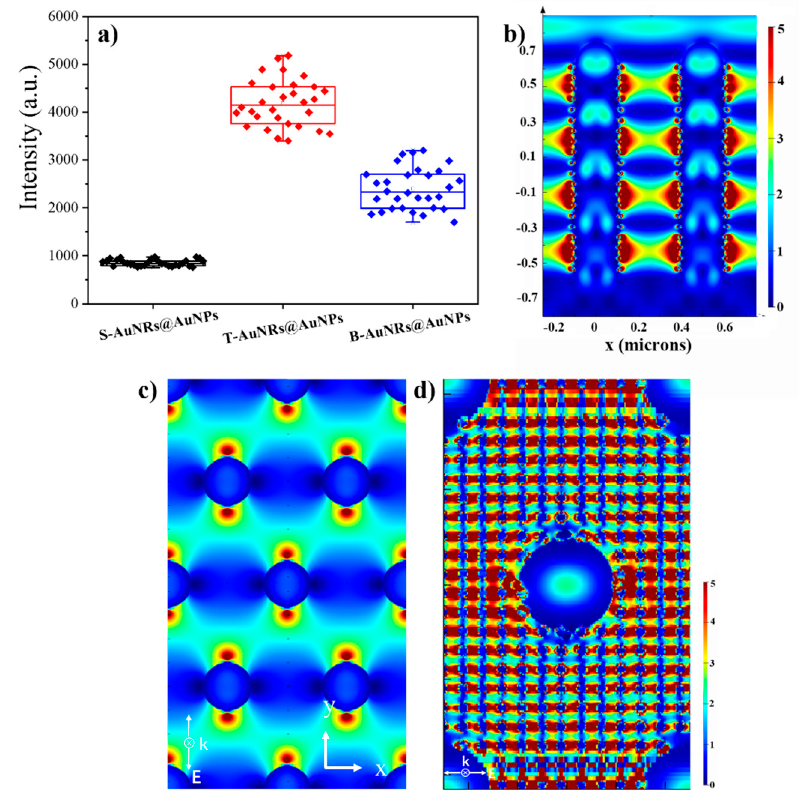
Figure 6. ( a ) Relative standard deviation of typical peak (1361 cm -1 ) from 10 Raman spectra; ( b ) FDTD simulation of the near-field electric field distribution of ordered SiNRs (left) and S-SiNRs@AuNPs (right) arrays. Both are side views of the structure. ( c ) Top view of the electric field distribution of S-SiNRs@AuNPs. ( d ) Top view of the electric field distribution of T-SiNRs@AuNPs.